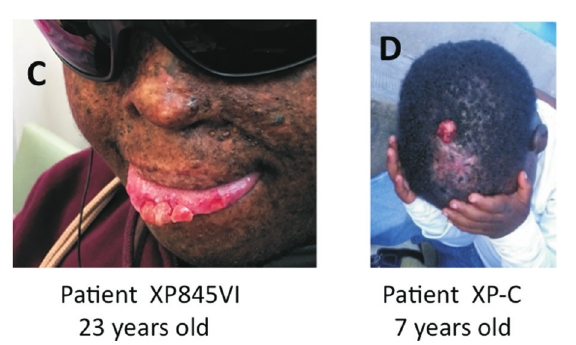
Figure 2 - Representative photographs of XP-C patients from Comoros and skin tumors induced by sun-exposure. A) and B) Pictures of the same patient (XP845VI) at two different ages (15 and 23 years old) showing the increasing hypo- and hyper-pigmentation of the black skin. C) Shows a growingtumoronthetipofthetongueoftheXP845VIpatientattheageof 23 as well as small skin tumors on the face. D) Shows a squamous cell car- cinoma on the head of a 7-year-old XP-C patient. (Pictures reproduced with the authorization of the patients and their